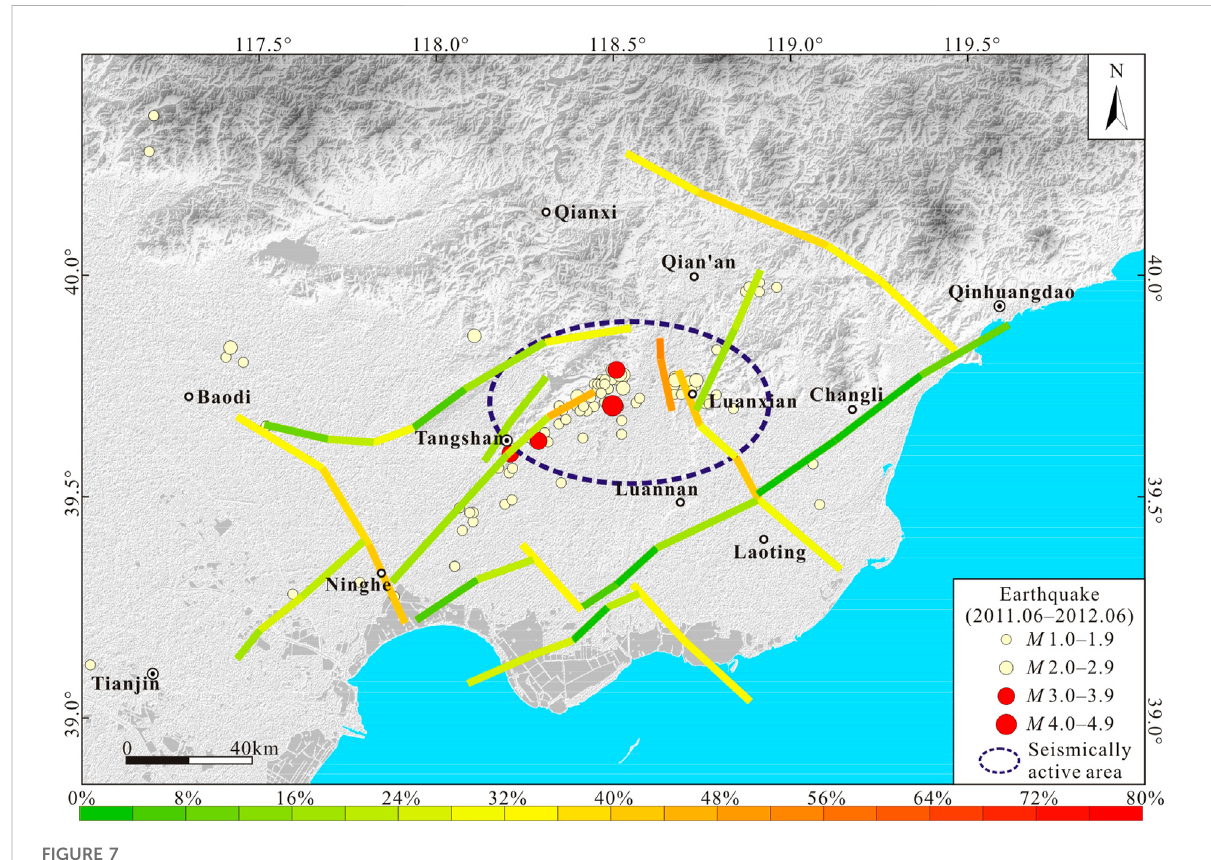
FIGURE 7 The fault slip potential on the main faults in Tangshan seismic region in stage